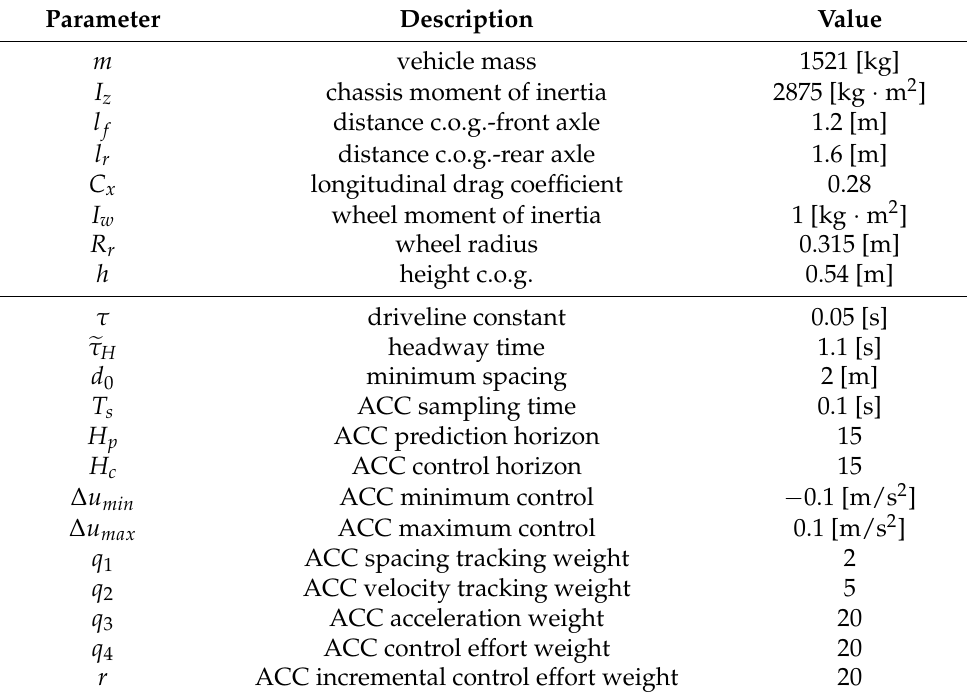
Table 1. Ego vehicle parameters used for simulation purposes and control tuning